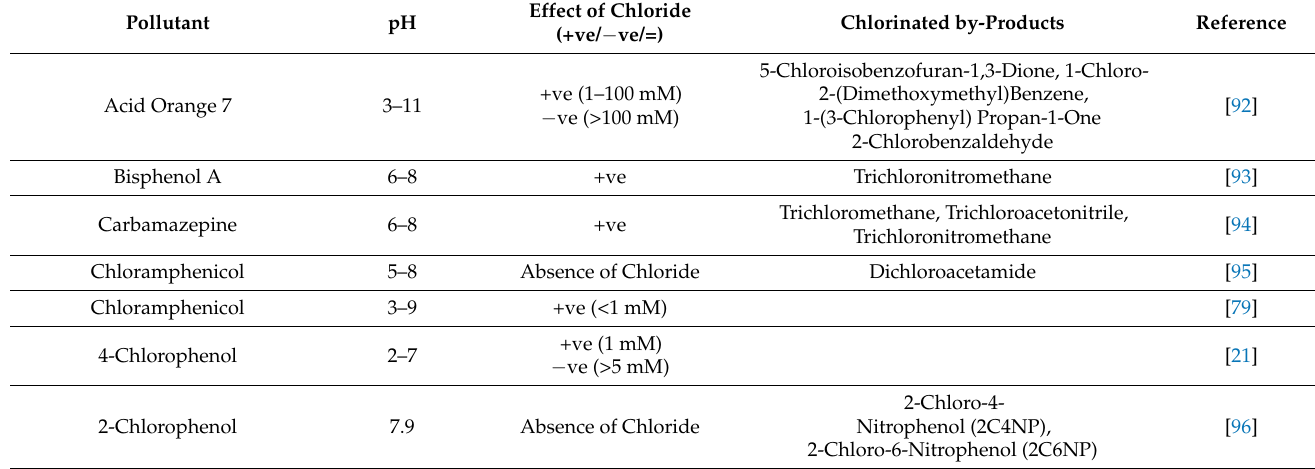
Table 2. Effect of chloride ion over pollutant degradation (+ve: Positive effect; − ve: negative effect), and formation of chlorinated